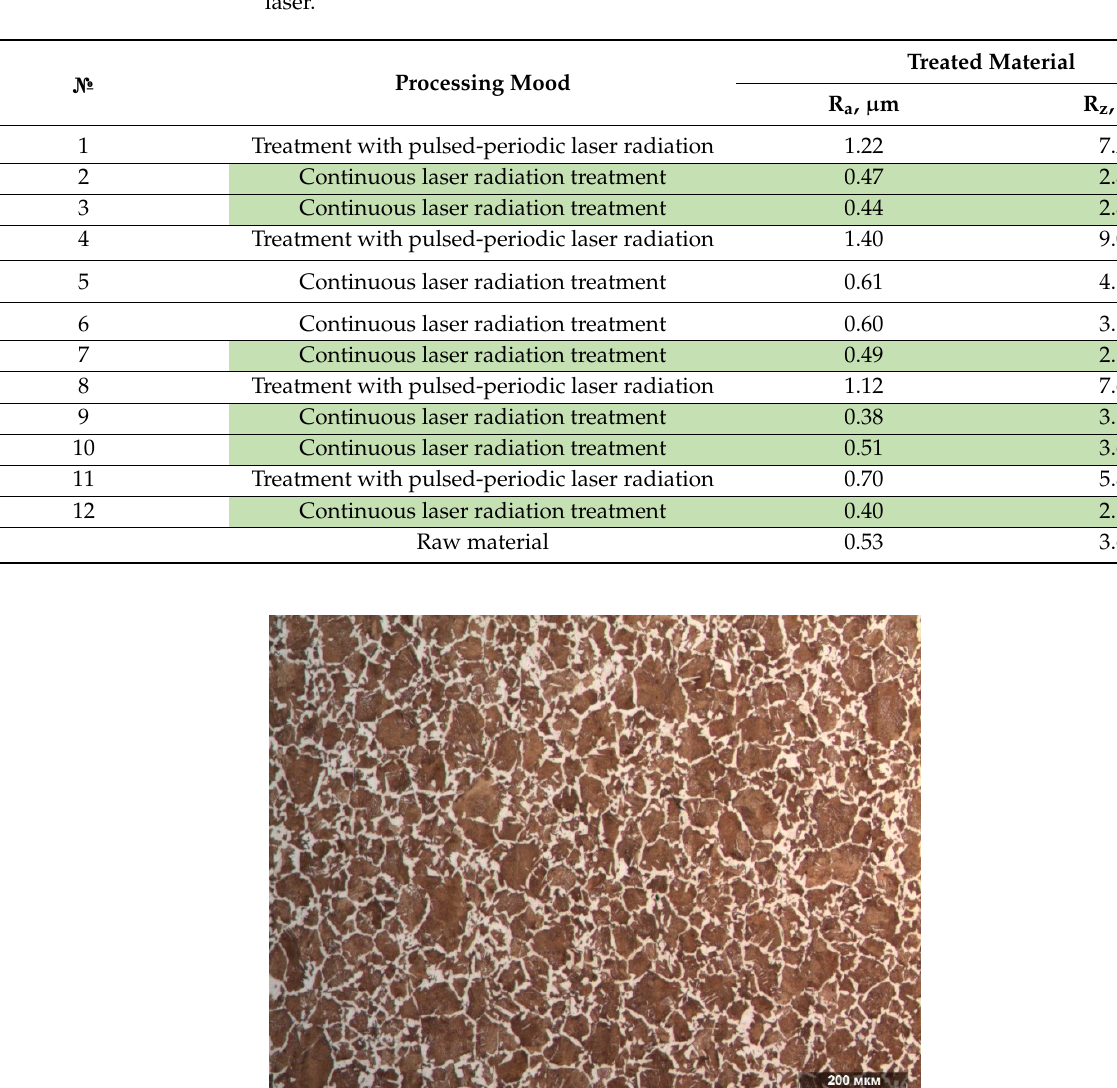
Table 3. The surface roughness of the model samples before and after laser treatment by Nd:YAG laser.